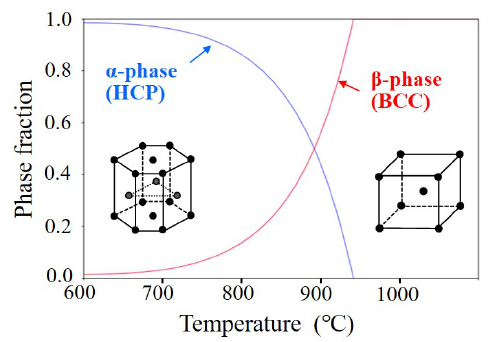
Figure 1. Phase fraction of